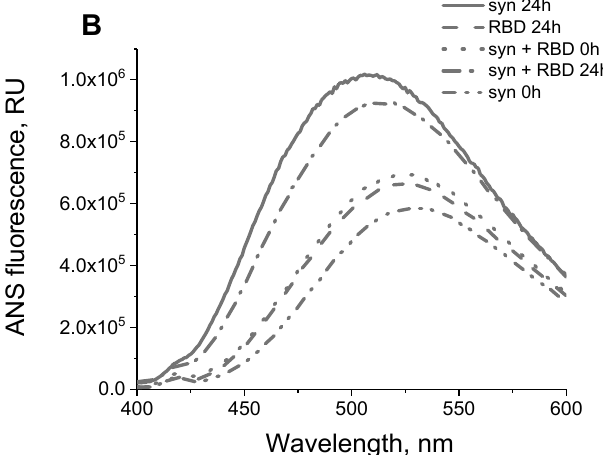
Figure 9. Structural changes of the SARS-CoV-2 RBD observed under fibrillization of alpha-synuclein by Trp and ANS fluorescence. Trp ( A ) and ANS ( B ) fluorescence emission spectra SARS-CoV-2 RBD (dashed line), 28 μ M alpha-synuclein and 5.6 μ M SARS-CoV-2 RBD (molar ratio 5:1) for 0 h (dash-dotted line) and 18–24 h (dotted line). Alpha-synuclein does not contain tryptophans (solid line for 18-24 h and dash-double-dot line for 0 h).